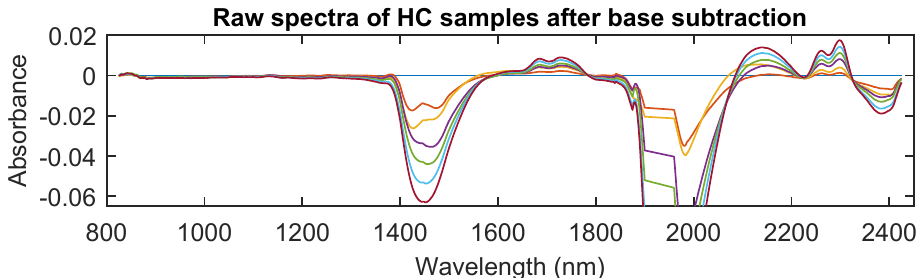
Figure 4. NIR spectra of high concentration samples after base lactate correction. The peaks identified due to the stretching and bending of C-H bonds are visible at 2259, 2299, 1684, and 1730 nm. The absorption at these peaks is linear with the concentration of NaLac in the sample.